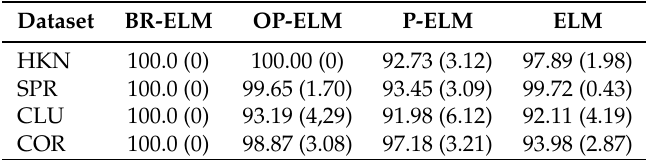
Table 2. Accuracies of the model in the tests performed.